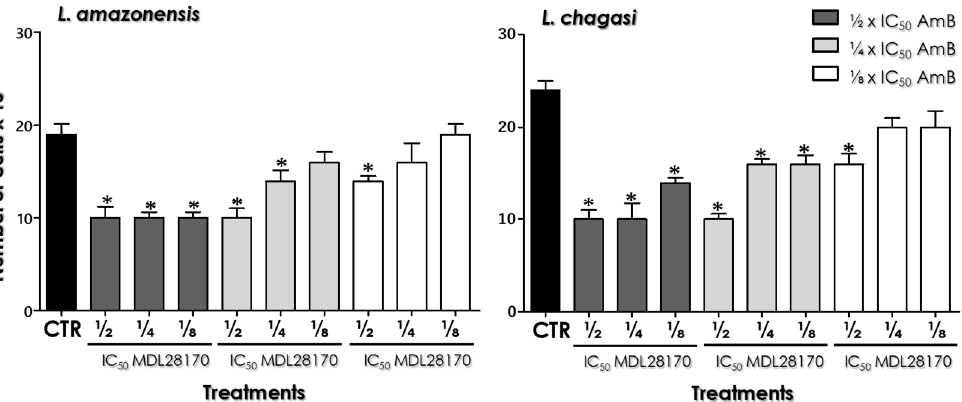
Figure A2. Effects of the combination of Amphotericin B (AmB) and MDL28170 on the growth rate of L. amazonensis and L. chagasi . Promastigotes were incubated or not (Control, CTR) with combinations of both drugs at the concentrations corresponding to the ⅛ , ¼, or ½ × IC 50 /48 h values of each drug and cell proliferation was measured after 48 h. Results represent mean ± standard deviation of three independent experiments performed in triplicate and the asterisks highlight significant differences when compared to control ( p < 0.05).